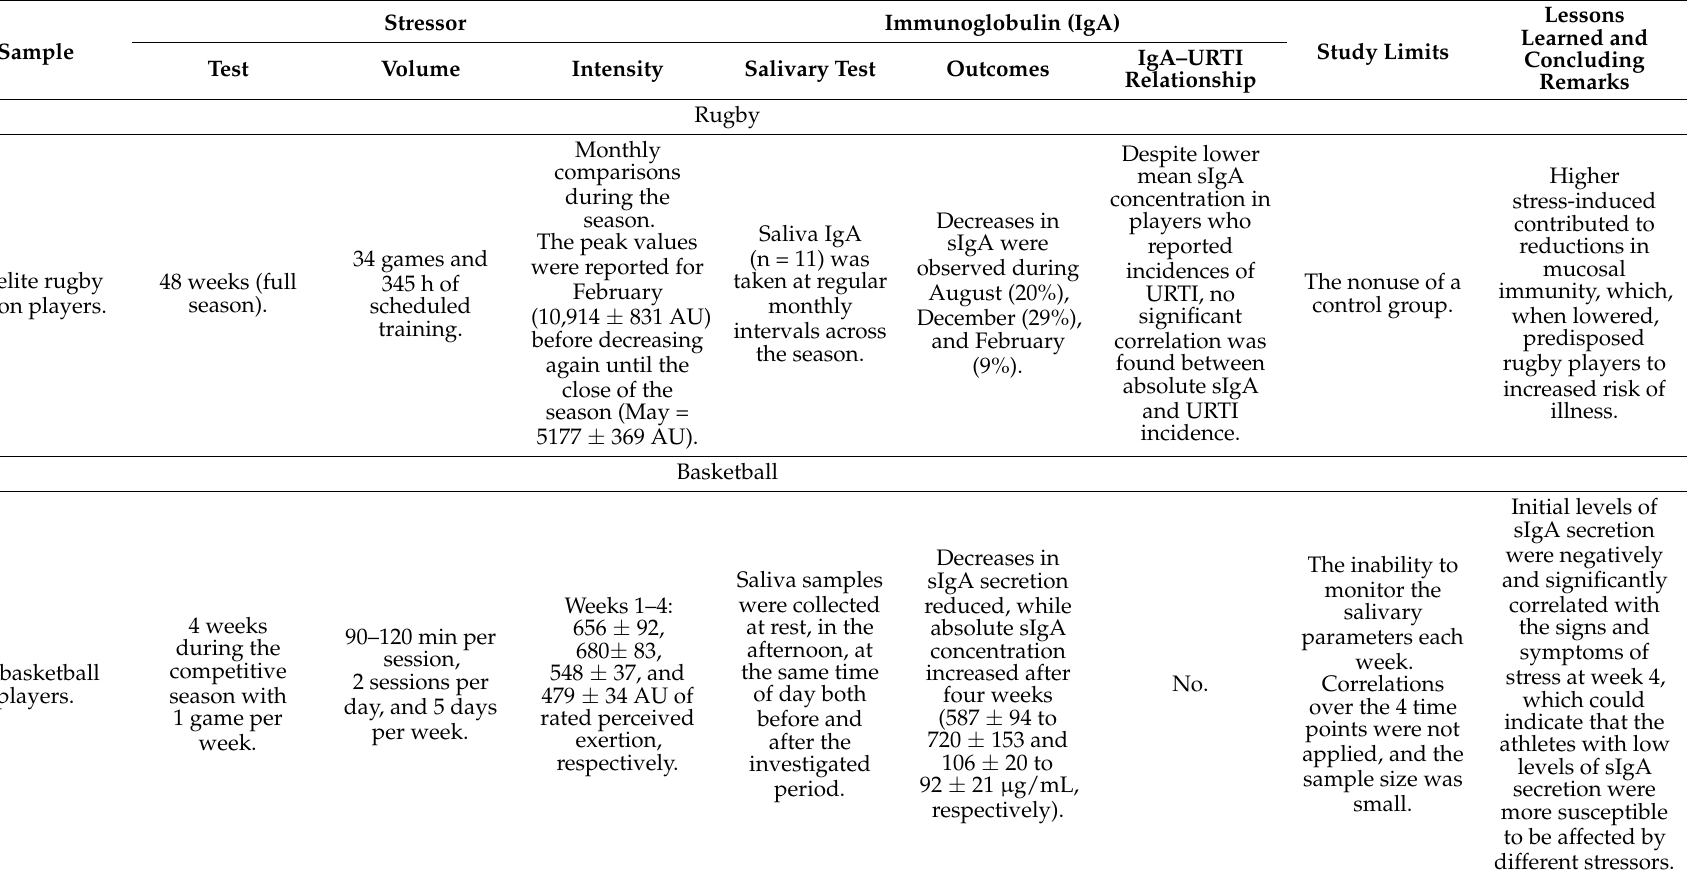
Table 5. Immunoglobulin A responses during both training and match load and its relationship with URTI.